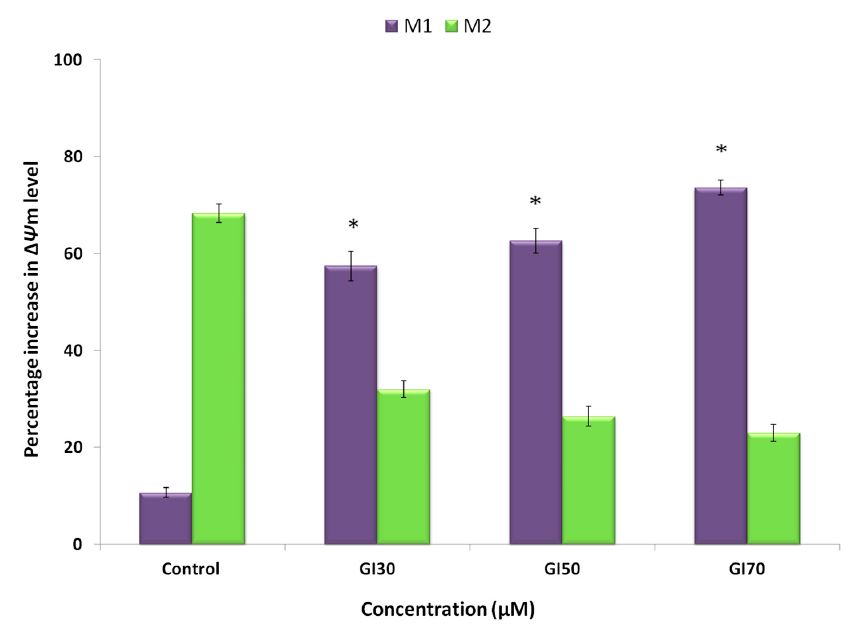
Figure 13. Effect of Epiafzelechin from C. fistula on the disruption of mitochondrial membrane potential ( Δ Ψ m) in MG-63 cells detected by staining with Rhodamine-123. Twenty-thousand events were acquired and the gated population analyzed using flow cytometry. M1 represents cells with the disruption of Δ Ψ m and M2 represents the intact cells. * indicates a statistically significant difference at ( p ≤ 0.05).